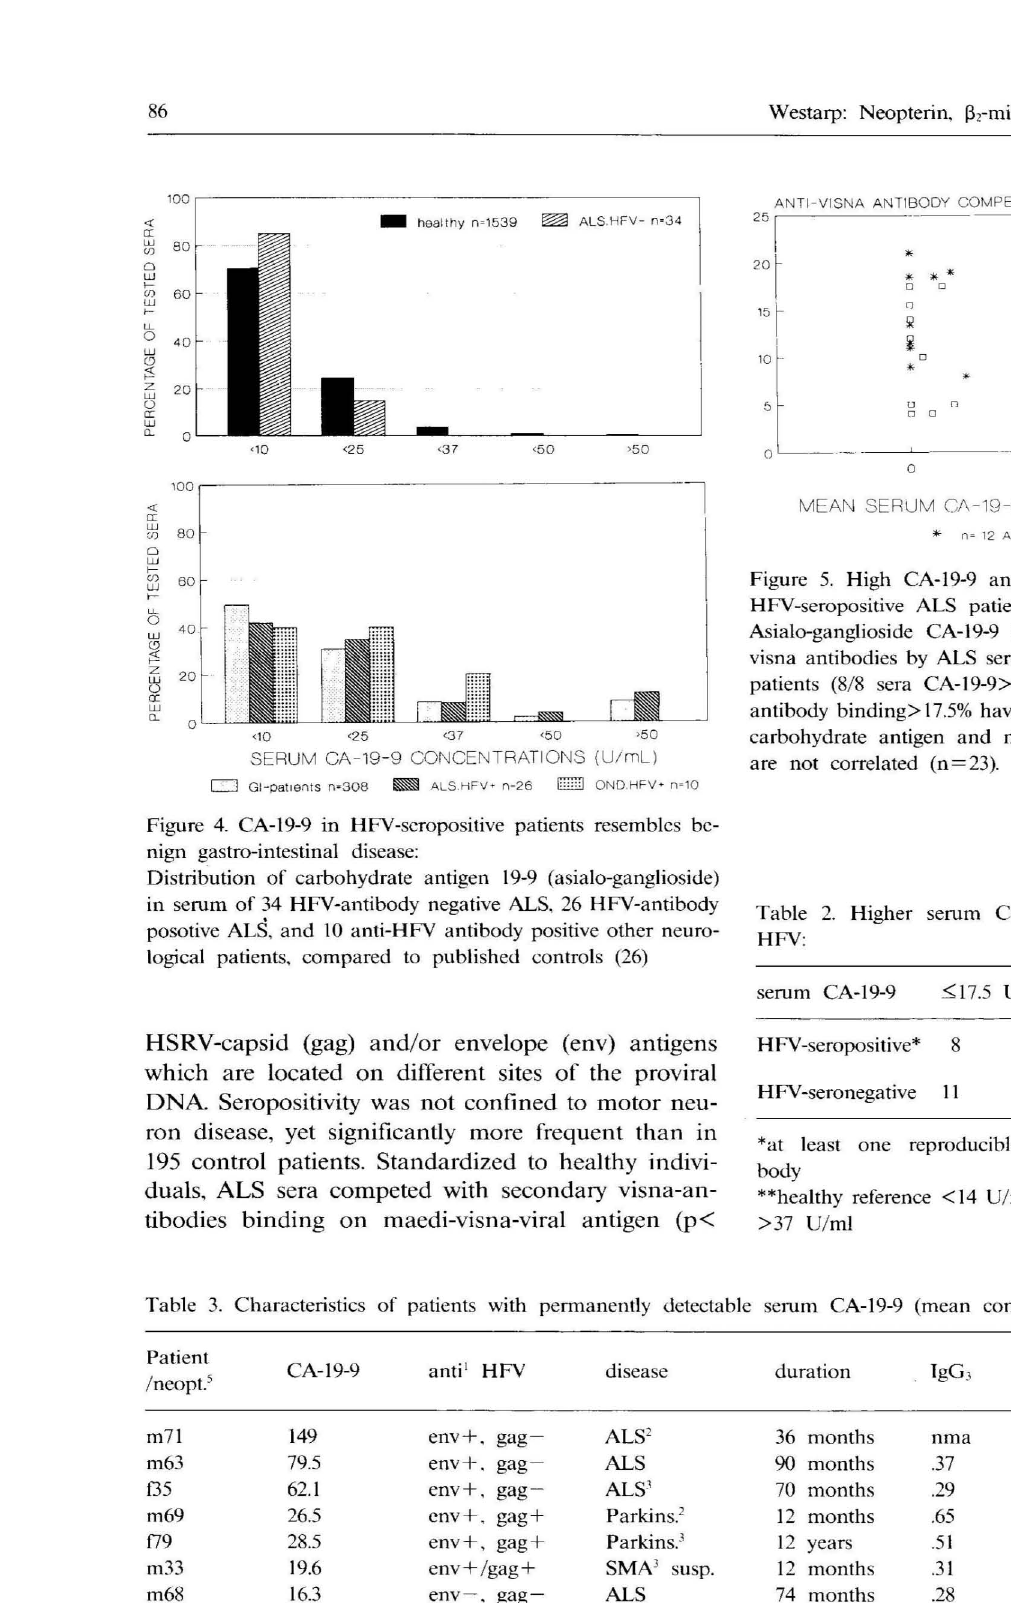
Table 3. Characteristics of patients with permanently detectable serum CA-19-9 (mean concentrations> 14 U/ml):